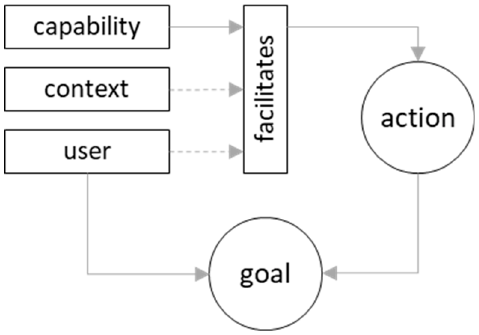
Figure 4. Components defining technological affordances.